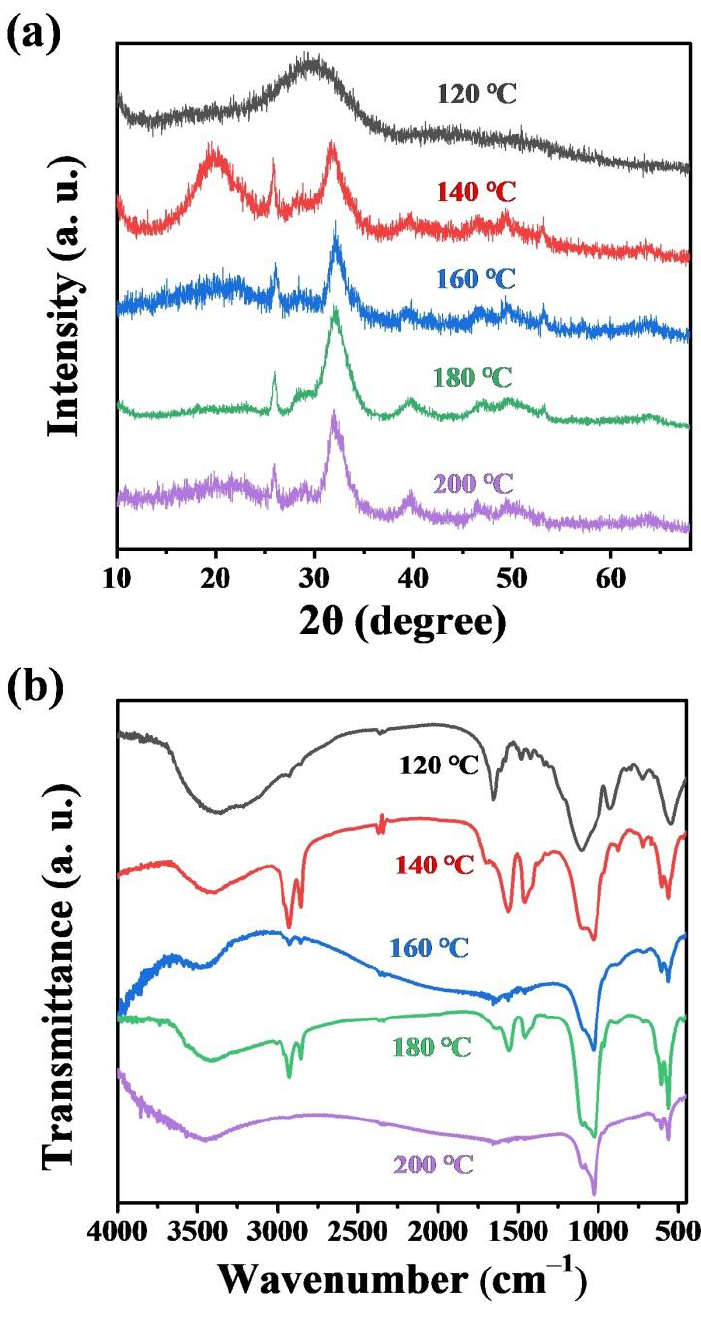
Figure 7. XRD patterns ( a ) and FTIR spectra ( b ) of the products prepared using ATP as a bio-phosphorus source in aqueous solution by the calcium oleate precursor microwave hydrothermal method for 60 min at different temperatures.